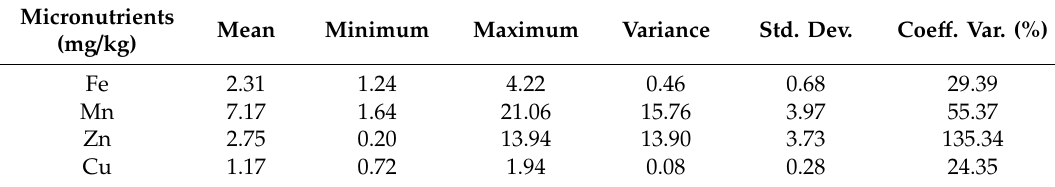
Table 1. Soil micronutrients descriptive